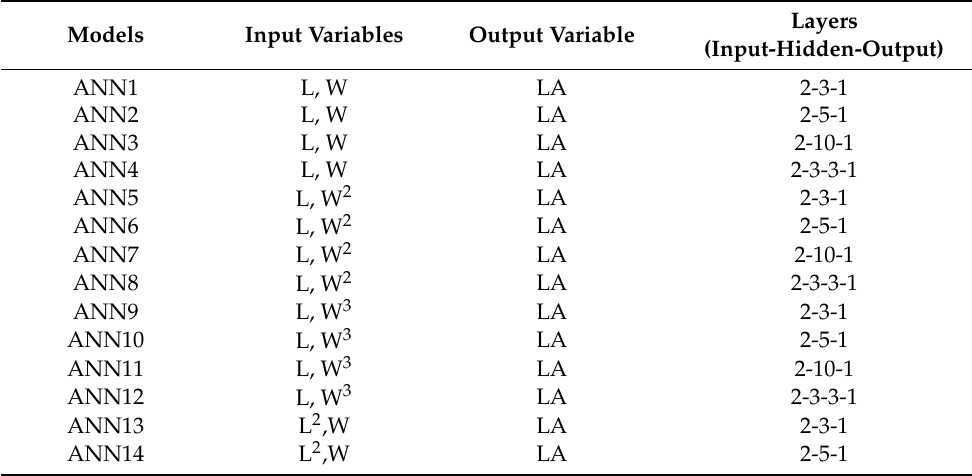
Figure 3. ANN network structures used in this study includes three types of layers. Input layer (with input neuron i 1 and i 2 ) taking values from leaf length (L) and leaf width (W), hidden layer (H 1 , H 2 ) (with hidden neuron h k , where k = 3 or 5 when architecture has single hidden layer and k = 3 when architecture has double hidden layer) and output layer (with output neuron O 1 ) were utilized to predict the leaf area (LA). Furthermore, 4 × 9 = 36 models of ANN were developed. W and f depict the weights and sigmoid activation function, respectively. Table 2. Combination of different inputs for ANN techniques with different ANN